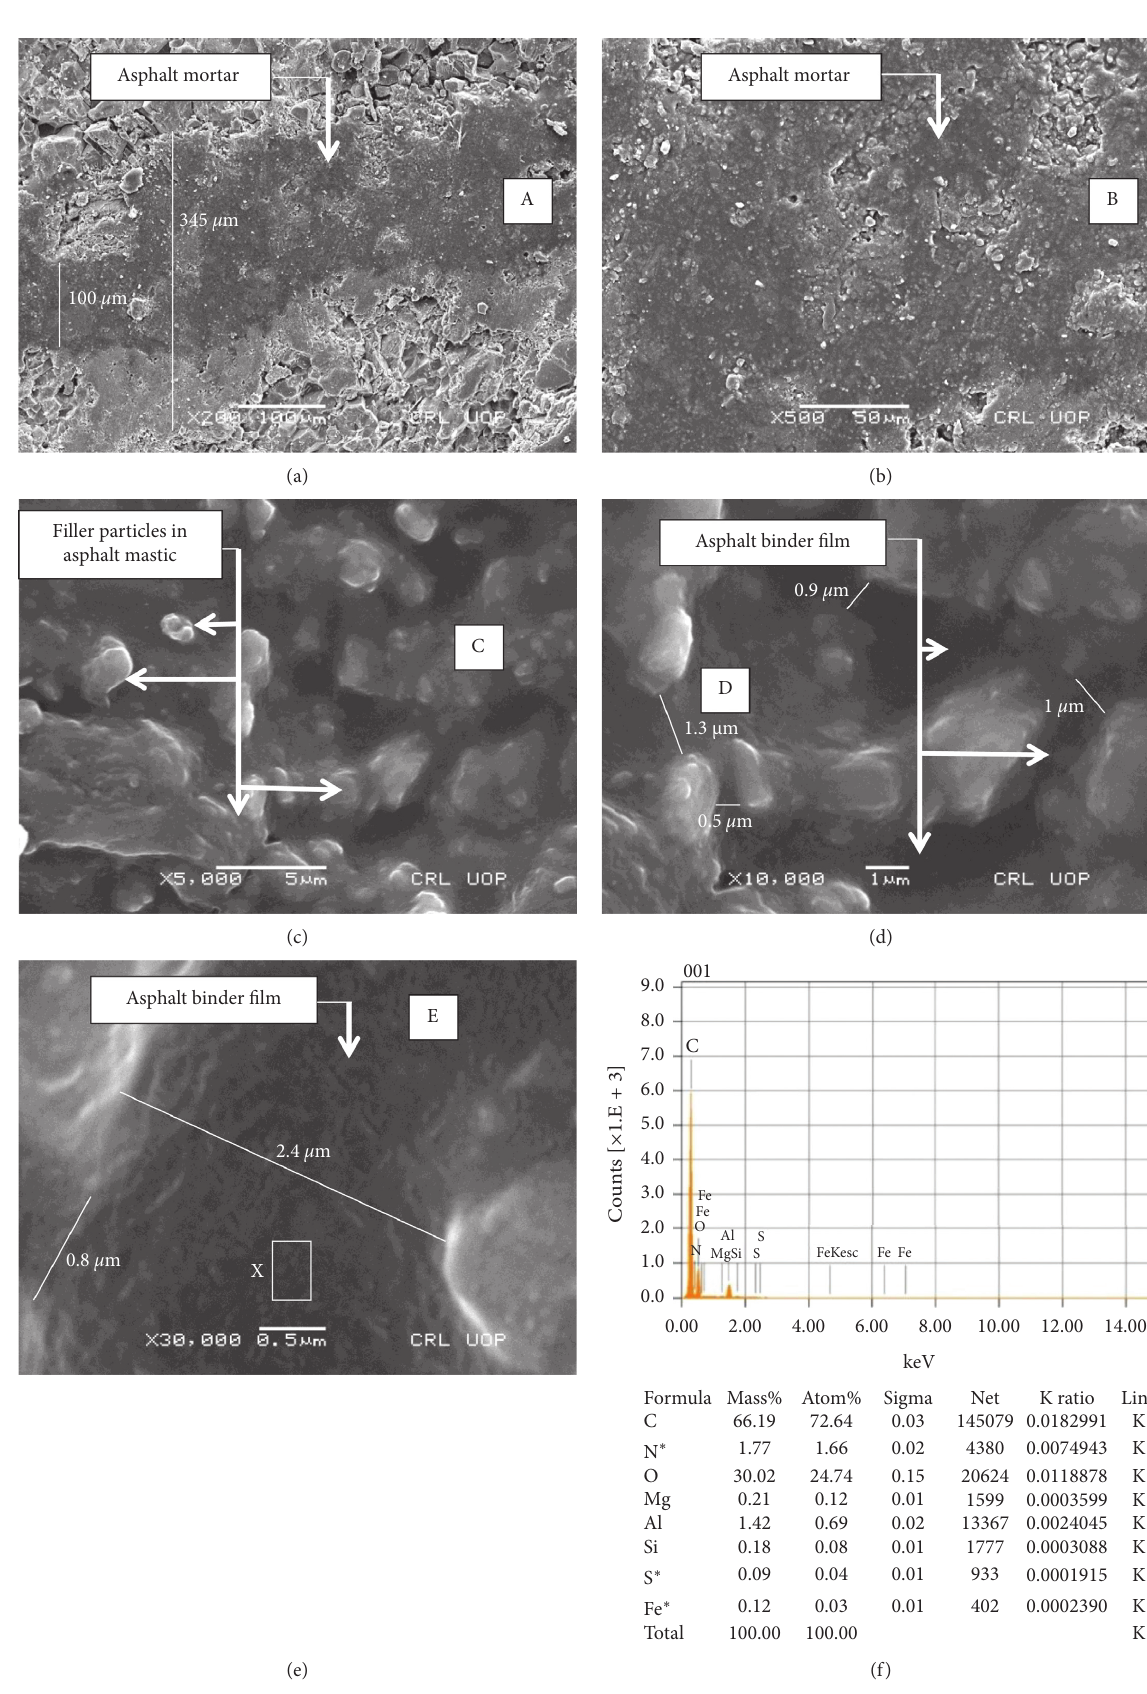
Figure 8: SEM images of HMA at 140 ° C and optimized binder content of 4.36%: (a) asphalt mortar at magnification × 200 and bar scale 100 μ m. (b) Asphalt mortar at magnification × 500 and bar scale 50 μ m. (c) Filler particles at magnification × 5000 and bar scale 5 μ m. (d) Asphalt binder film at magnification × 10,000 and bar scale 1 μ m. (e) Asphalt binder film at magnification × 30,000 and bar scale 0.5 μ m. (f) Elemental composition of asphalt binder film at point X in image (e) by